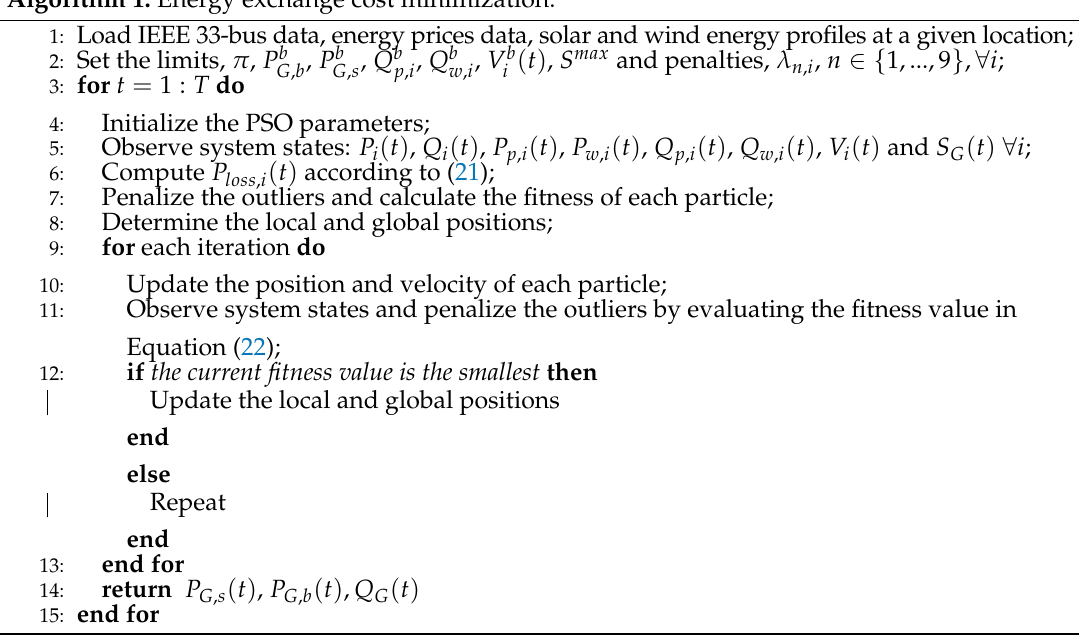
Algorithm 1: Energy exchange cost